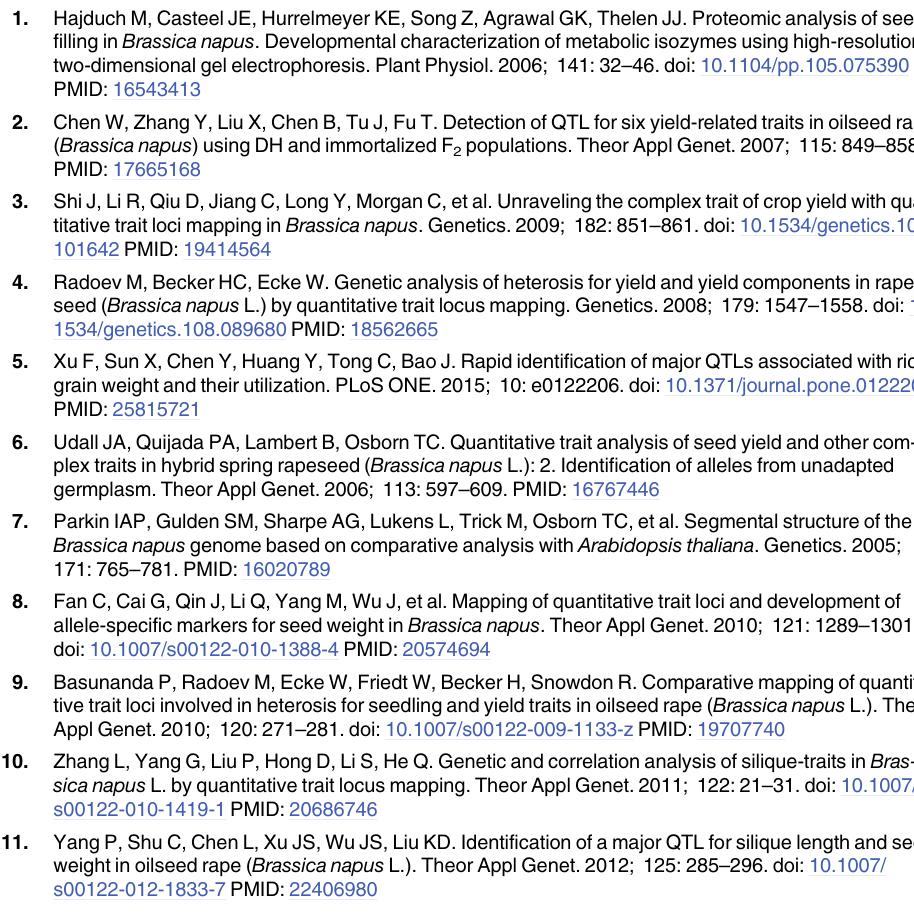
S3 Table. Annotation information for 91 candidate